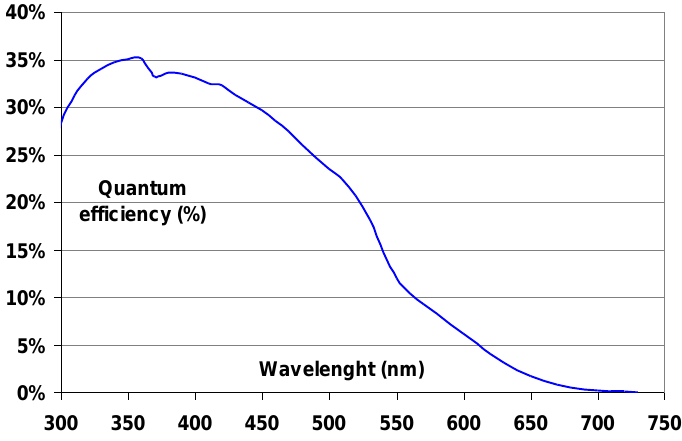
Figure 5. Quantum efficiency of a typical CR scanner